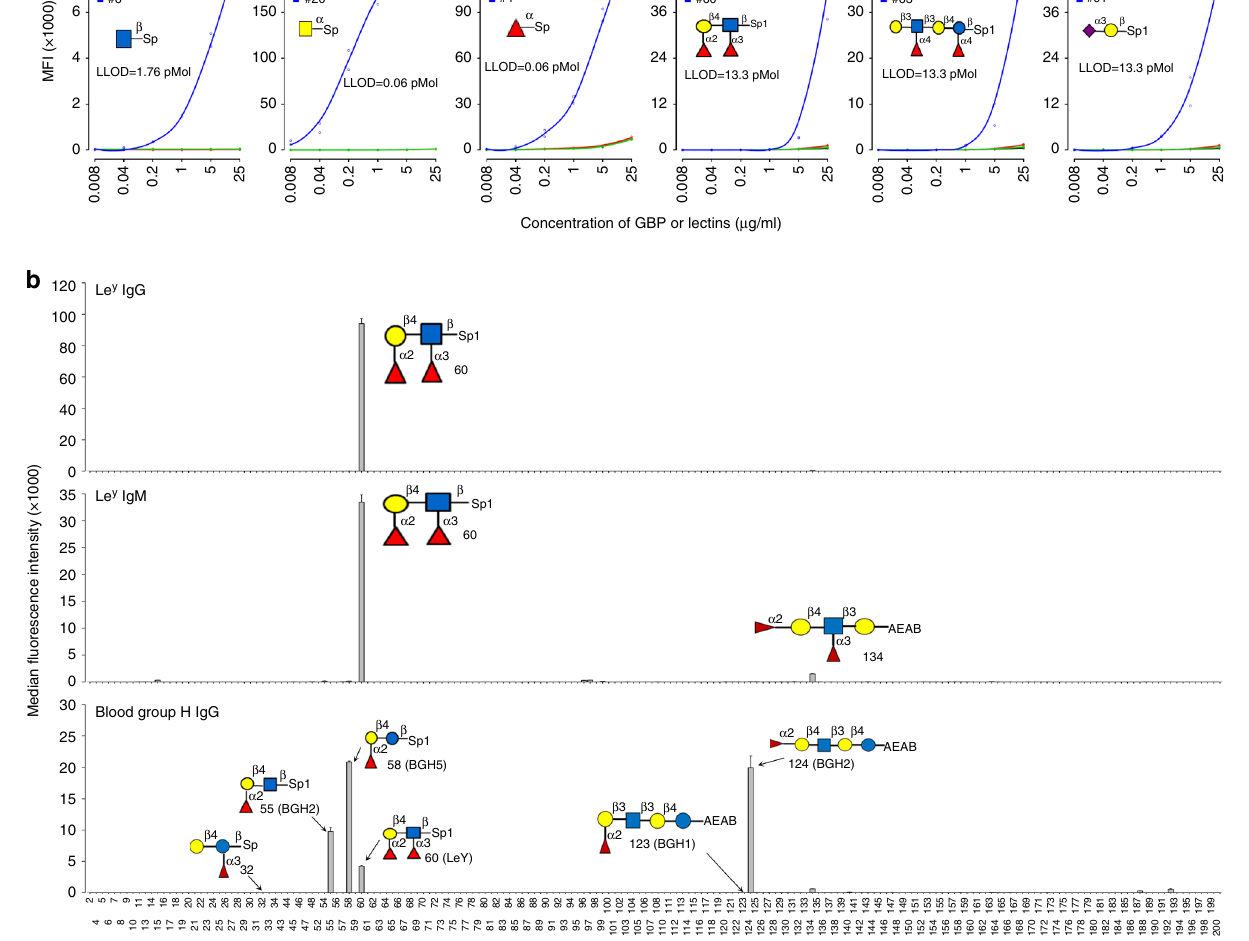
Fig. 3 Evaluation of MGBA ’ s sensitivity and speci fi city. a Serial dilutions of lectins and GBPs were used to assess the lower limit of detection of MGBA. Lowest limit of detection values were 1.76pMol (GSL-II), 0.06pMol (VVL and AAL) and 13.3pMol (E-Selectin). b Speci fi city for anti-glycan antibodies. The data for three representative antibodies are shown here and the data for other antibodies are shown in Supplementary Fig. 6. The glycans with similar structures without binding are also presented in the fi gure to show speci fi city of the binding. Mean of two replicates is presented and error bars are standard deviations of the two replicates. Each experiment was repeated three